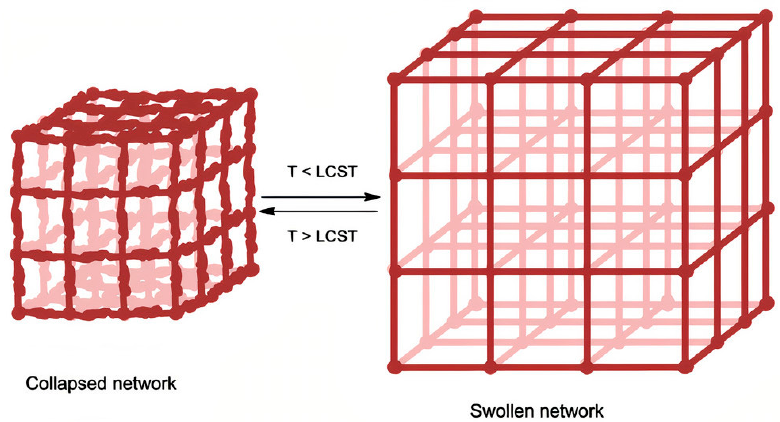
Figure 3. Effect of temperature on the swelling of covalently linked networks in LCST polymers. Reprinted with permission from Ward, M., and Georgiou, T. Thermoresponsive Polymers for Biomed- ical Applications. Polymers 3(3). Copyright (2011) MDPI [77].